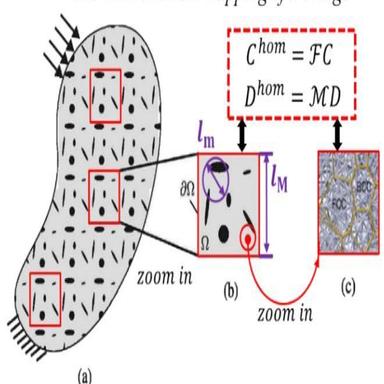
Macroscopic and microscopic mapping diagram.